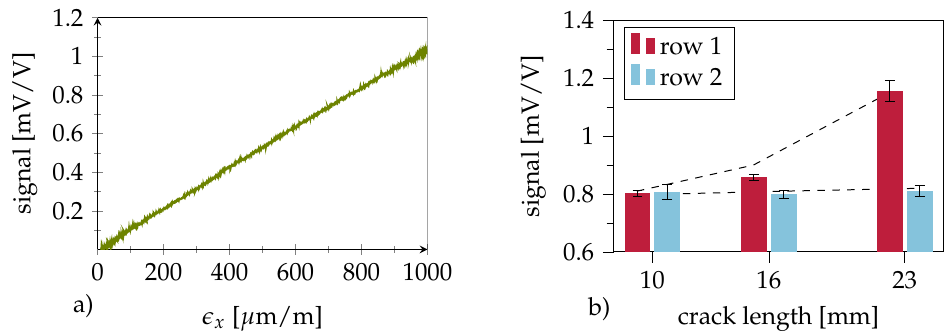
Figure 10. ( a ) Sensor calibration: Specimen was loaded using a ramp signal up to a maximum strain of 1000µmm − 1 . ( b ) Mean signal amplitudes for statically strained specimens with various artificial crack lengths. Standard deviation is represented in the form of brackets. FE simulated results are shown by a dashed